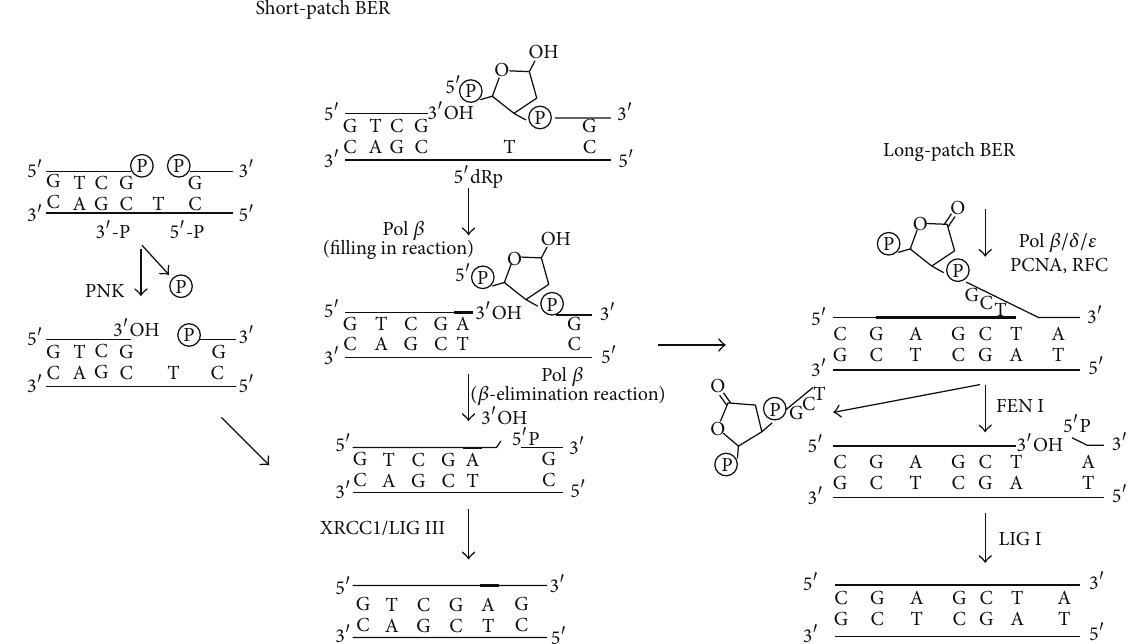
Figure 1: Simplified scheme for the short- and long-patch base excision repair